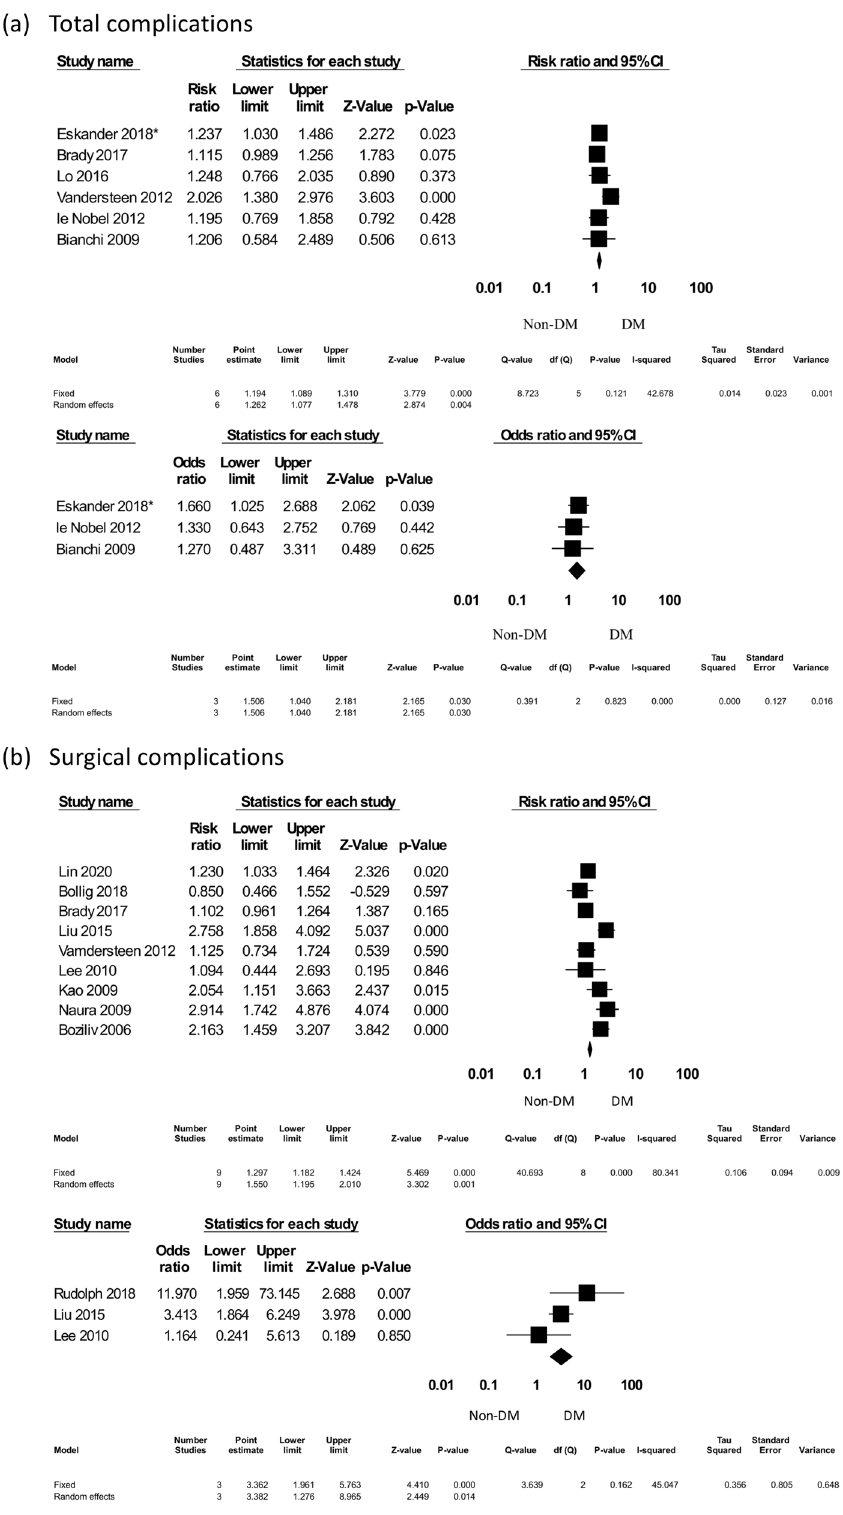
Figure 3. The postoperative complications forest plot: total and surgical complications. *Eskander 32